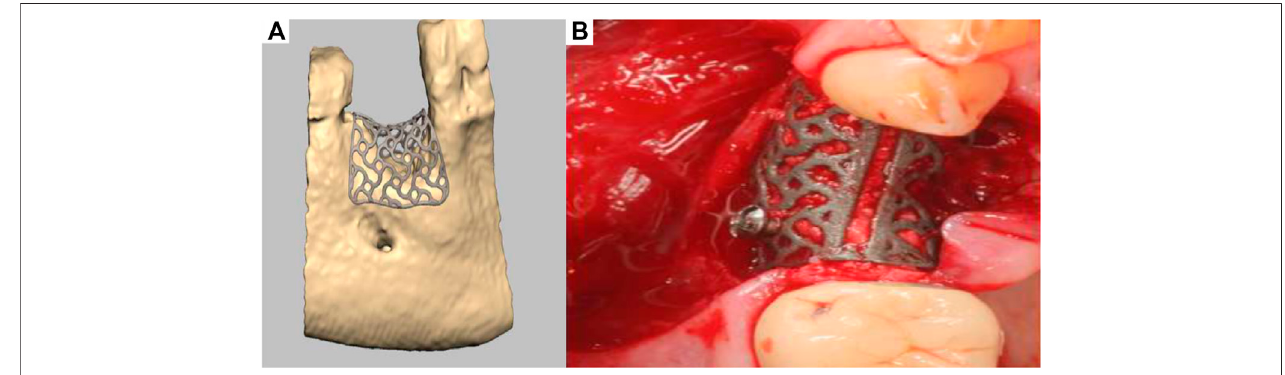
FIGURE 11 | Titanium 3D-printed mesh for vertical bone augmentation. (A) : numerical model of the titanium mesh, (B) : clinical placement. Reproduced with permission from (Seiler et al., 2018).